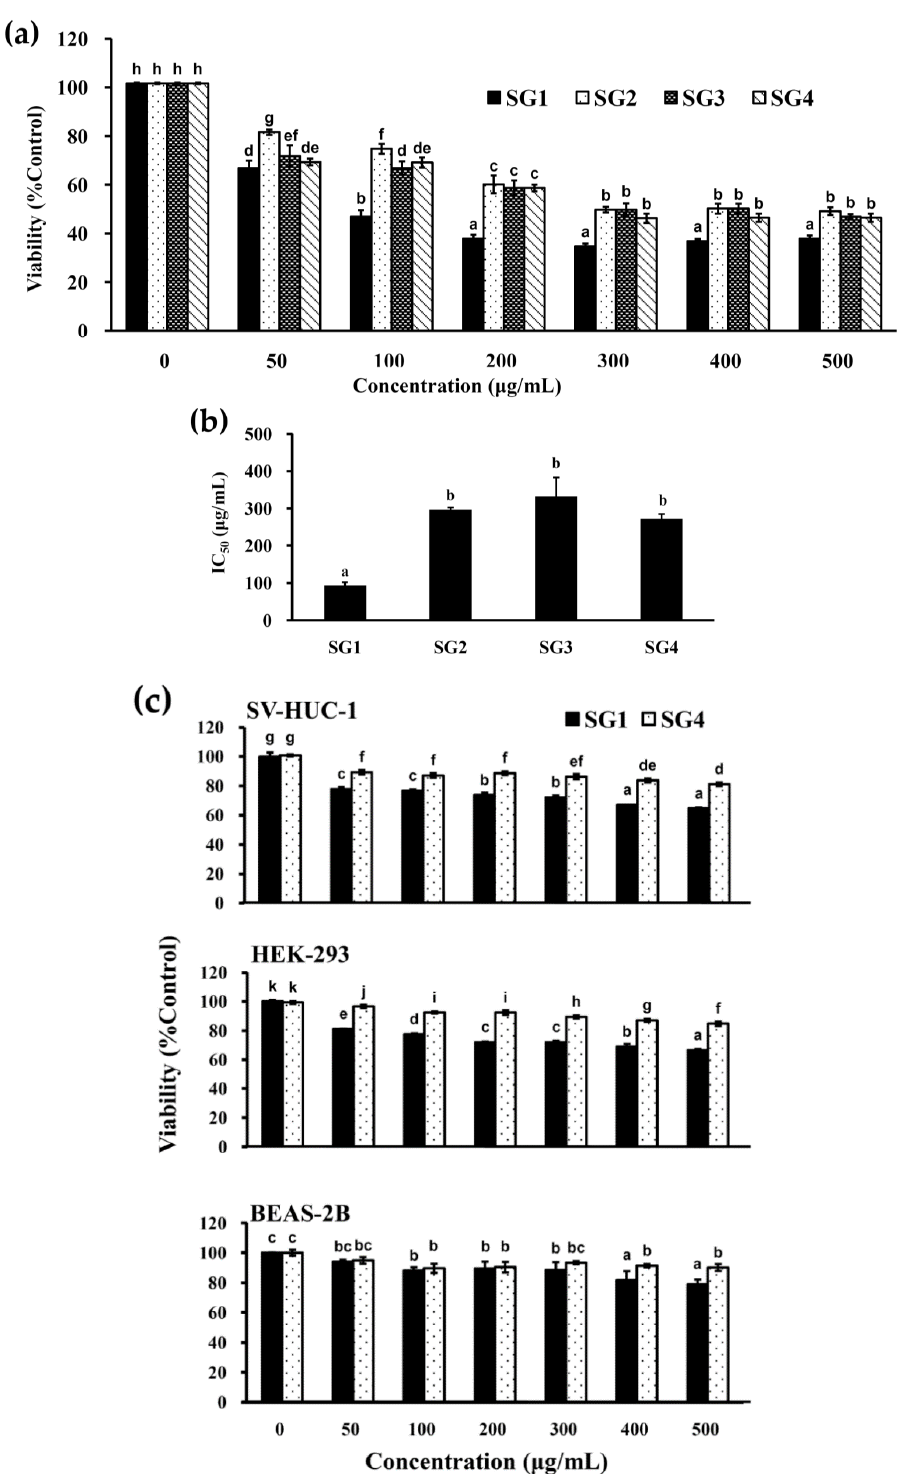
Figure 1. E ff ects of crude extracts of fucoidans (SG1-SG4) on cell viabilities of HT-29, SV-HUC-1, HEK-293, and BEAS-2B cells: ( a ) HT-29 cells were treated with varying concentrations of SG1-SG4 for 48 h, and cell viability was assessed; ( b ) the IC 50 values of SG1-SG4 to HT-29 cells are presented as determined for ( a ). ( c ) SV-HUC-1, HEK-293, and BEAS-2B cells were coincubated with varying concentrations of SG1-SG4 for 48 h, and cell viability was evaluated. The experiments were run in triplicate. Differences existing between columns are labeled with different letters, p < 0.05.